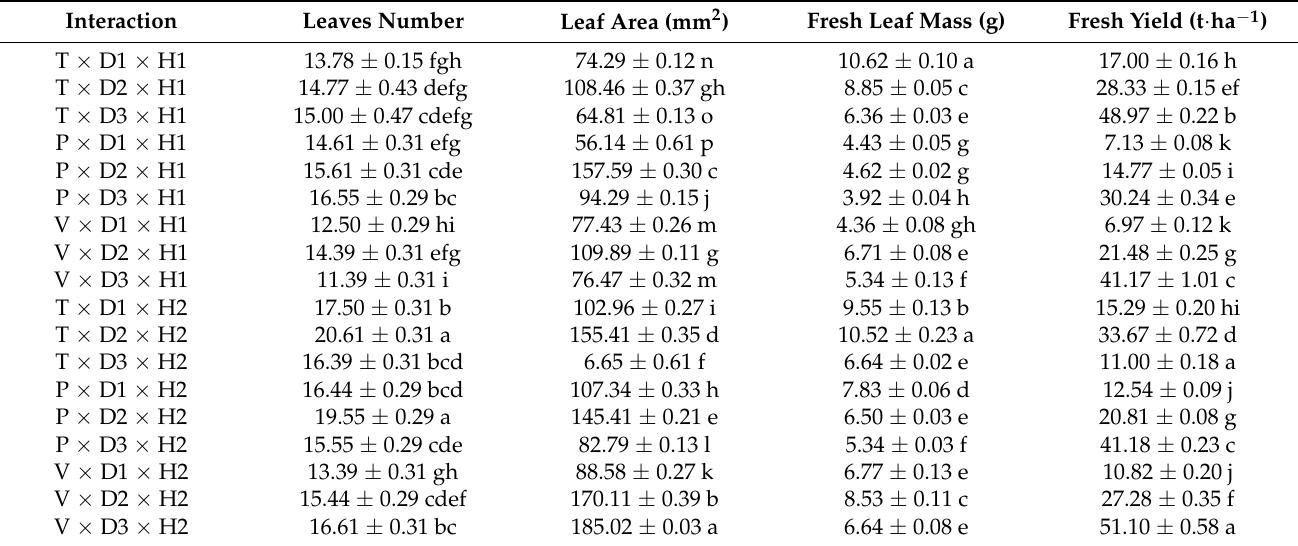
Table 4. Cultivar, plant density and harvesting time interaction effect on quinoa leaf cultivars.